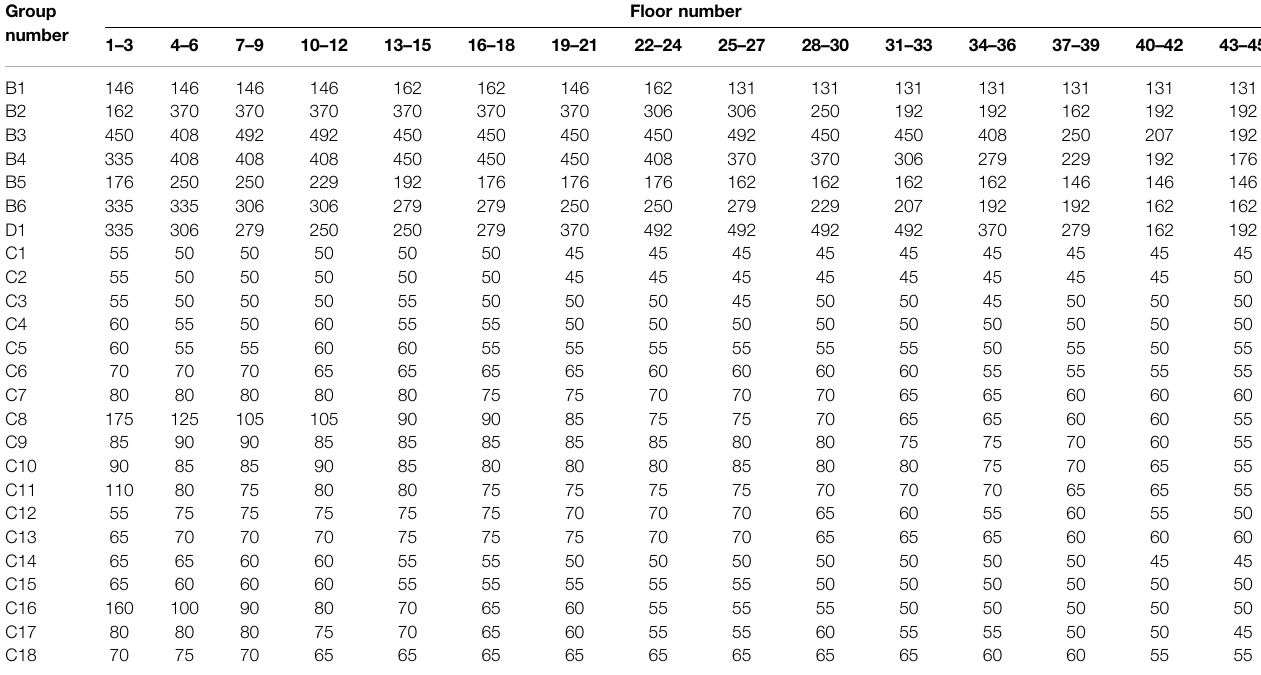
TABLE 4 | Member sizes for the structural system. D1 indicates diagonals while W24 sections are identi fi ed through their weight per unit length using imperial units. Box sections are identi fi ed in terms of their mid-line width in